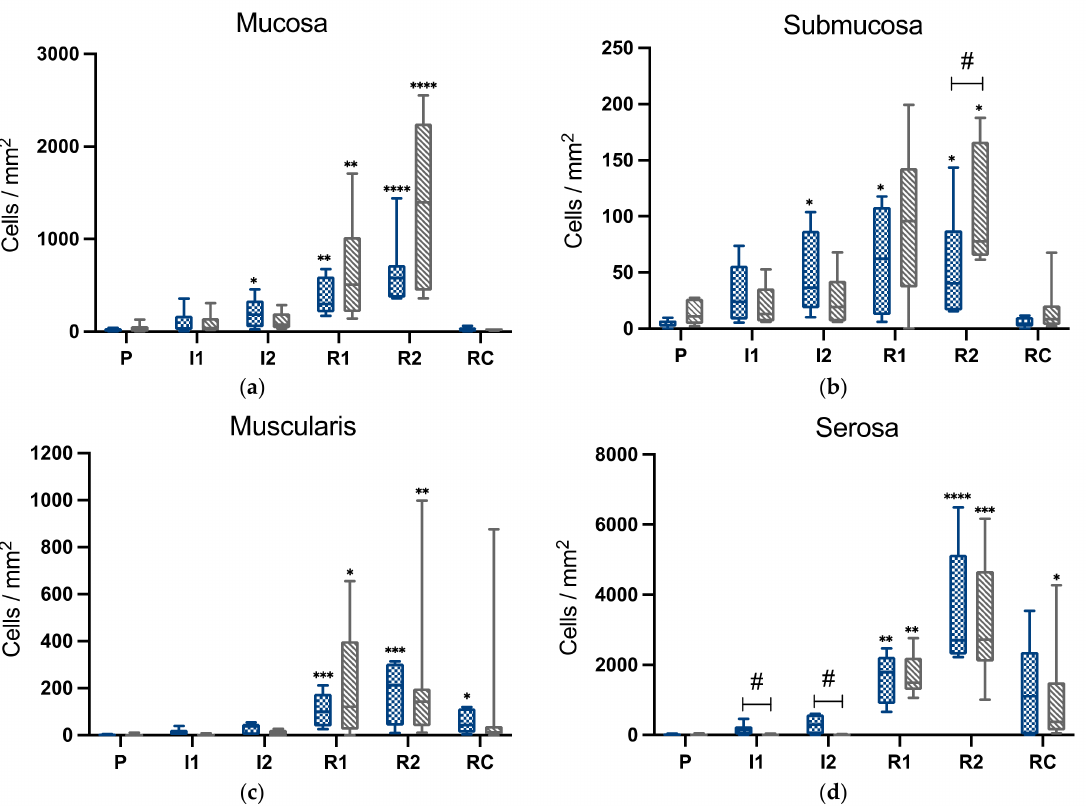
Figure 9. Box-plot diagram of positive cell counts in cells/mm 2 after immunohistochemical staining for cytosolic calprotectin in the mucosa ( a ), submucosa ( b ), muscularis ( c ) and serosa ( d ) of jejunum subjected to either LF or NF ischaemia at different time points. P, pre-ischaemia; I1, 60 min ischaemia; I2, 120 min ischaemia; R1, 60 min reperfusion; R2, 120 min reperfusion; RC, remote control sample at reperfusion. Significant differences of the time points compared to pre-ischaemia are marked with an asterisk (* p < 0.05; ** p < 0.01; *** p < 0.001; **** p < 0.0001), significant differences between the groups are indicated with a horizontal bar and accompanying hash (# p < 0.05).